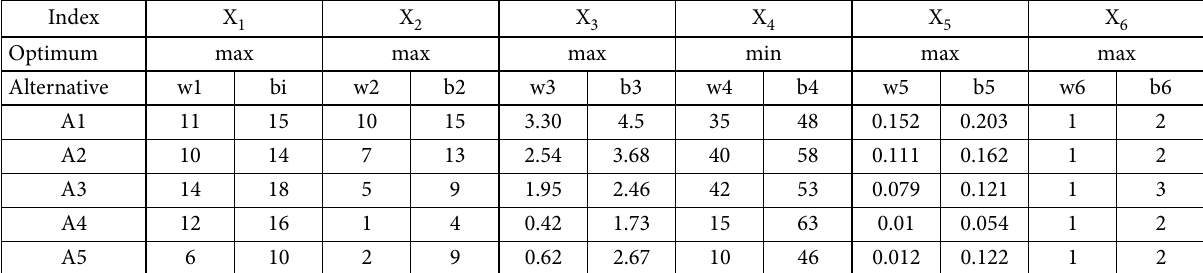
Table 7. Initial decision-making index values of contractor selection for construction works problem